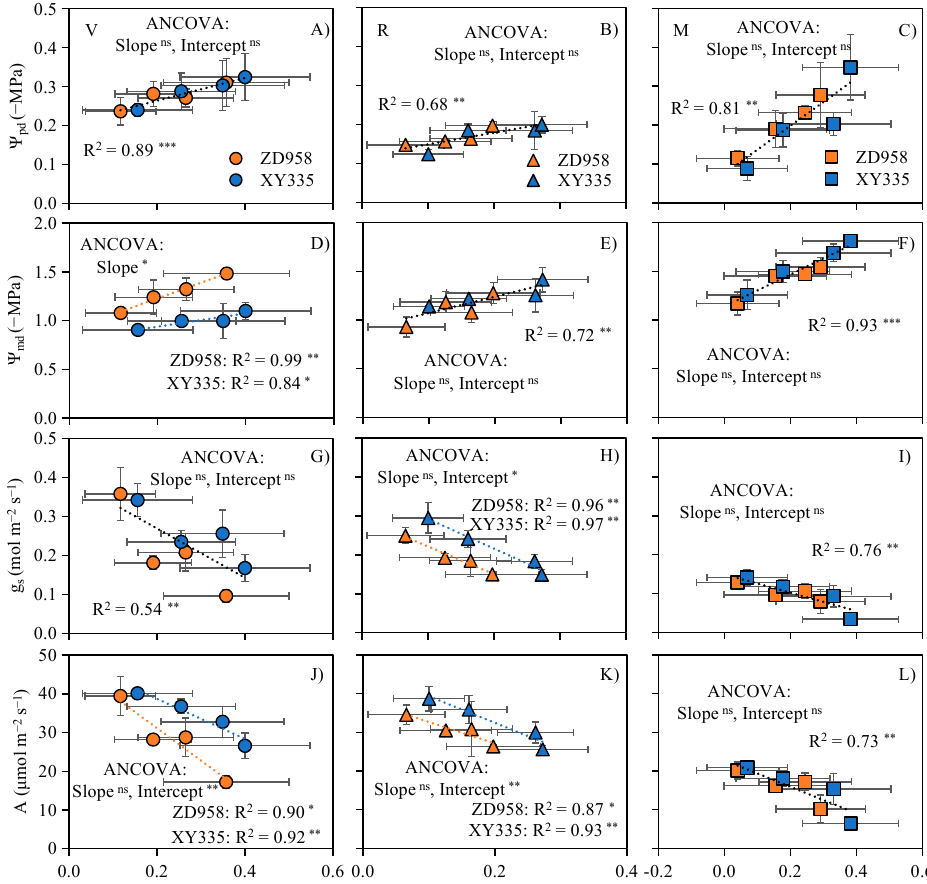
Figure 6. The relationships between predawn leaf water potential ( Ψ pd ), ( A – C ), midday leaf water potential ( Ψ md ), ( D – F ), stomatal conductance (g s ), ( G – I ), and net photosynthetic rate ( A ), ( J – L ) with average crop water stress index (CWSI) during different growth stages of two maize genotypes (ZD958 and XY335). Regression lines are fit for each genotype when either the slopes or intercepts are significantly different, and across all genotypes when both the slopes and intercepts are not significantly different by the ANCOVA test. Values are means ± SD. ns, no significant difference; *, p < 0.1; **, p < 0.05; ***, p < 0.001.